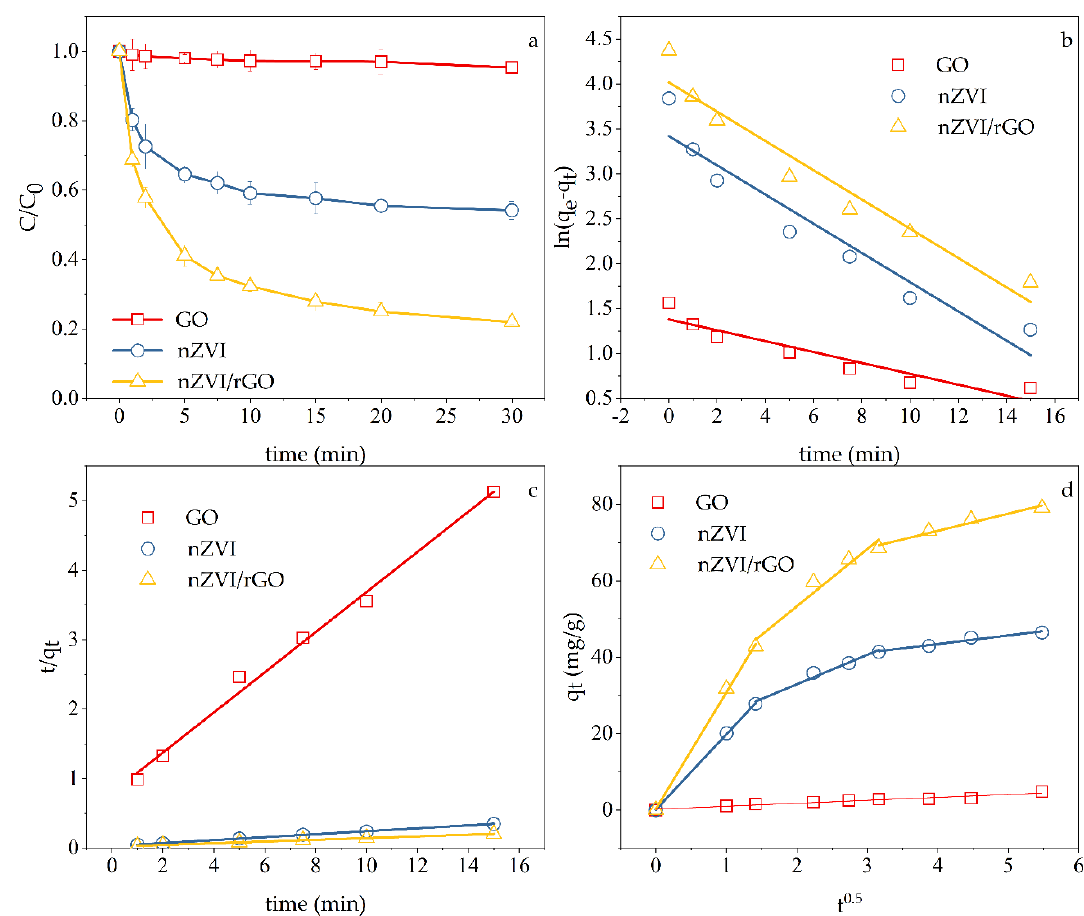
Figure 1. ( a ) Performance on Cr(VI) removal by different materials, ( b ) PFO models, ( c ) PSO models, and ( d ) intraparticle diffusion models. Experimental conditions: Temperature, 30 °C; pH = 5, initial concentration, 10 mg L − 1 ; dosage of adsorbents, 0.1 g L − 1 . Table 3. Parameters of the intraparticle diffusion models for different Table 2. PFO and PSO kinetic parameters for different materials.